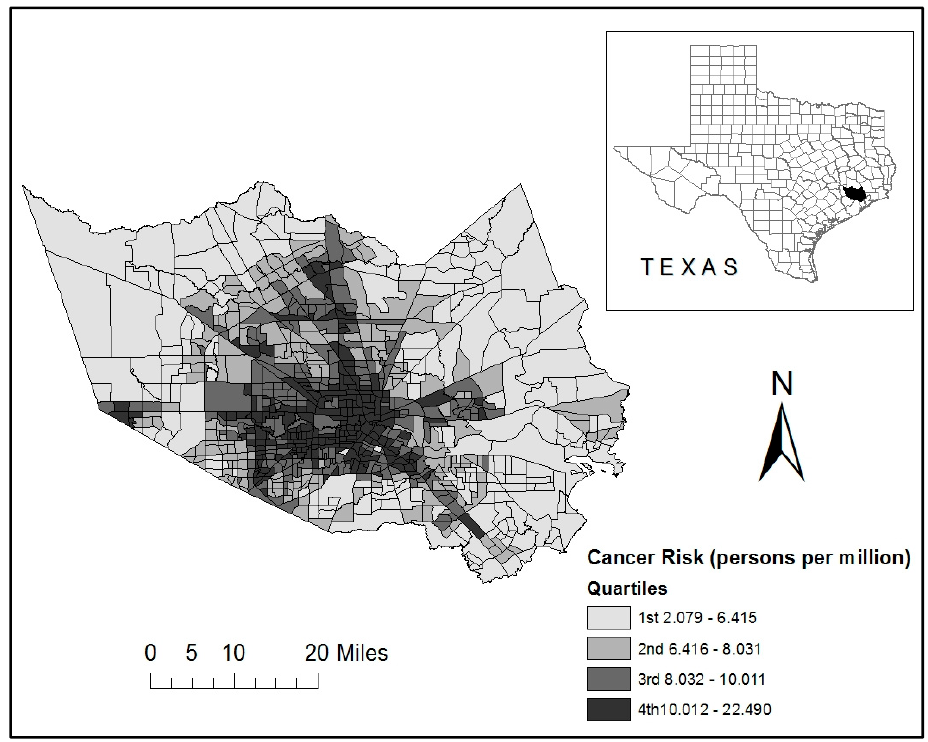
Figure 1. Distribution of on-road lifetime cancer risk by census tract in Harris County, Texas.